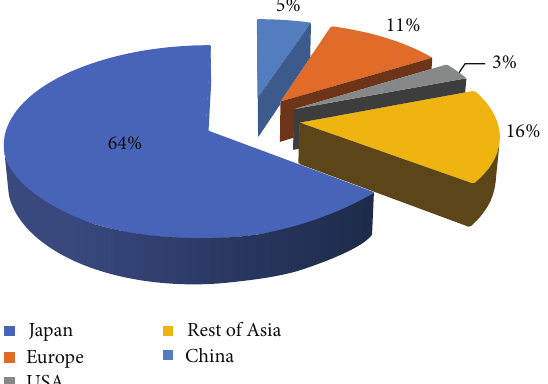
Figure 1: Electricity production in world in MW [2].